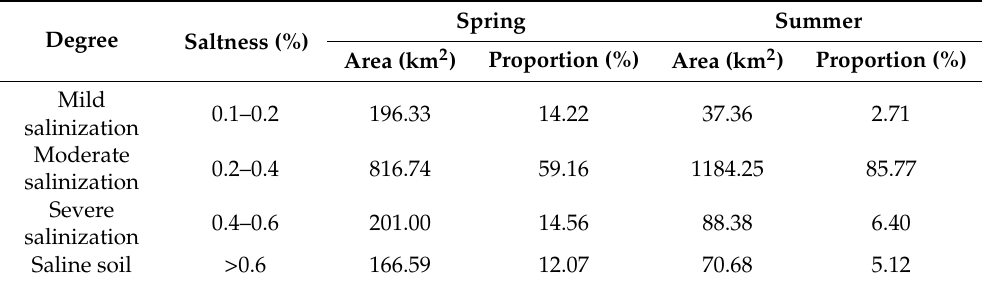
Table 5. Soil area with different degrees of